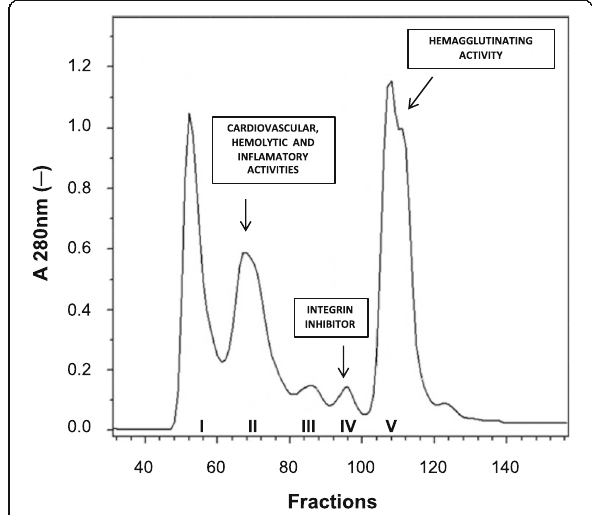
Fig. 3 Elution profile of the gel filtration fractionation of the Scorpaena plumieri extract (SpV). A sample of SpV (approximately 83 mg of protein) was applied on a Sephacryl S-200 HR column (2.0 cm × 120 cm) previously equilibrated and eluted with 0.01 M phosphate buffer at pH 7.6 with 0.4 M NaCl at 4 °C. Flow rate, 5.25 mL/h, fractions of 1.75 mL. Figure adapted from